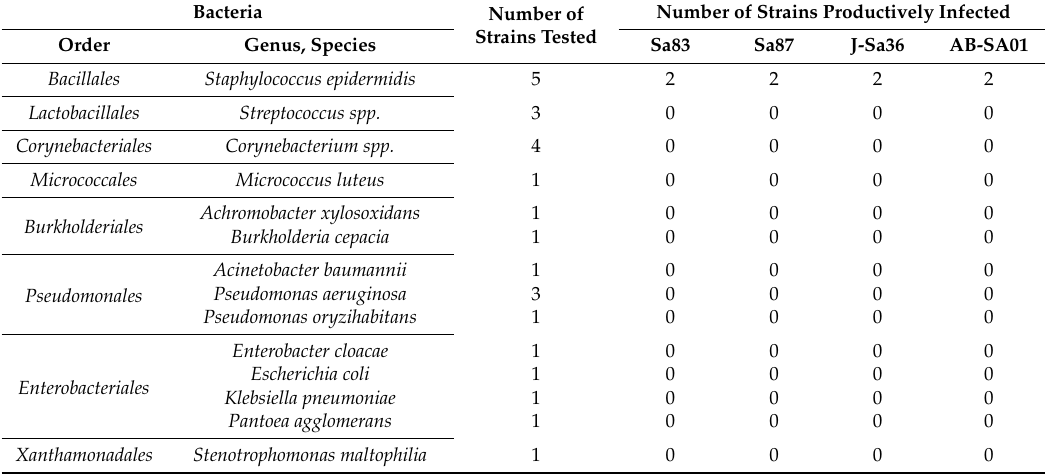
Table 2. In vitro activity of AB-SA01 and its component phages on bacterial species other than S. aureus .